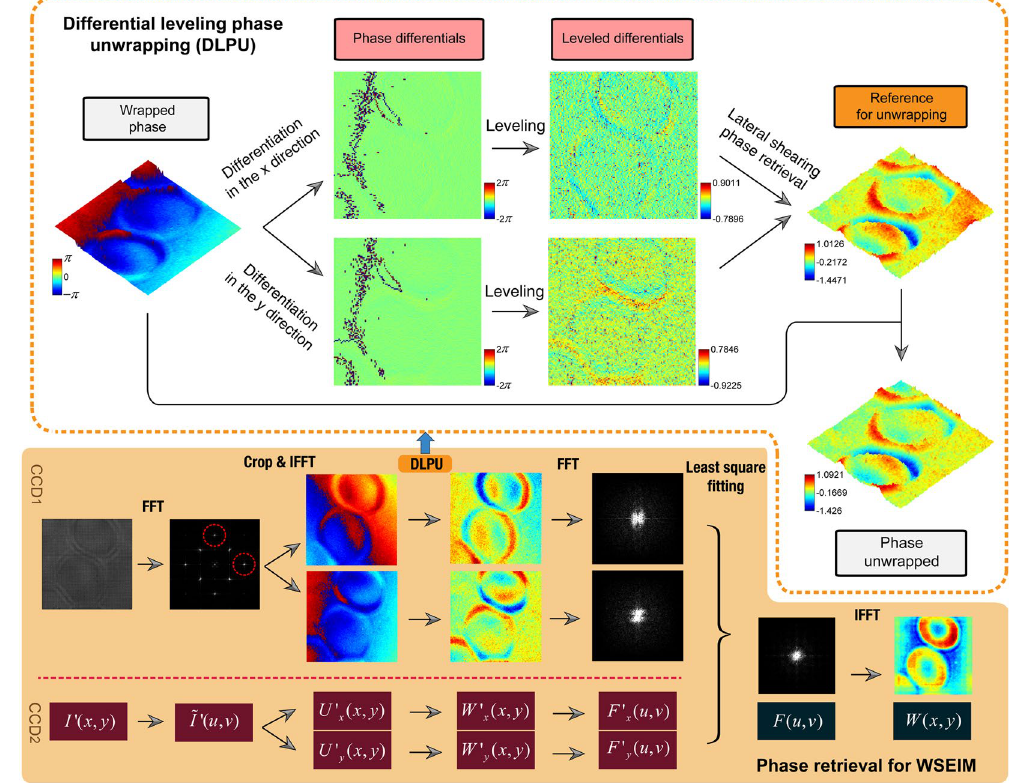
Figure 3. Schematics of the phase retrieval algorithm for WSEIM. The yellow box shows the flowchart of phase retrieval algorithm for WSEIM. The processing procedures in the phase retrieval for WSEIM contain FFTs, IFFTs and the differential leveling phase unwrapping (DLPU) algorithm. In the DLPU shown in the orange dashed box, phase differentials in the x and y directions are firstly obtained. Then the leveling procedure corrects the ± 2 π jumps in the differentials and a reference phase for unwrapping can be obtained from the leveled differentials by discrete Fourier transform lateral shearing phase retrieval algorithm. The difference in the unit of 2 π between the wrapped phase and the reference phase determines the number of 2 π that should be added or subtracted to the wrapped phase at each pixel for obtaining the unwrapped